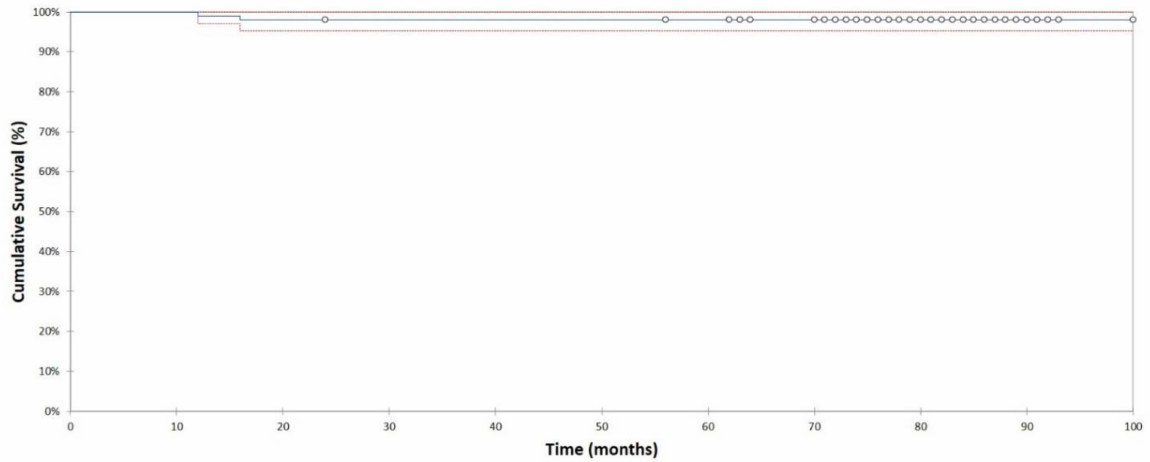
Figure 2. Kaplan-Meier survivorship curve and 95% confidence intervals with revision for any reason as the endpoint. 6.3-year survival was estimated at 98% (95% CI, 55–99%; 63 hips at